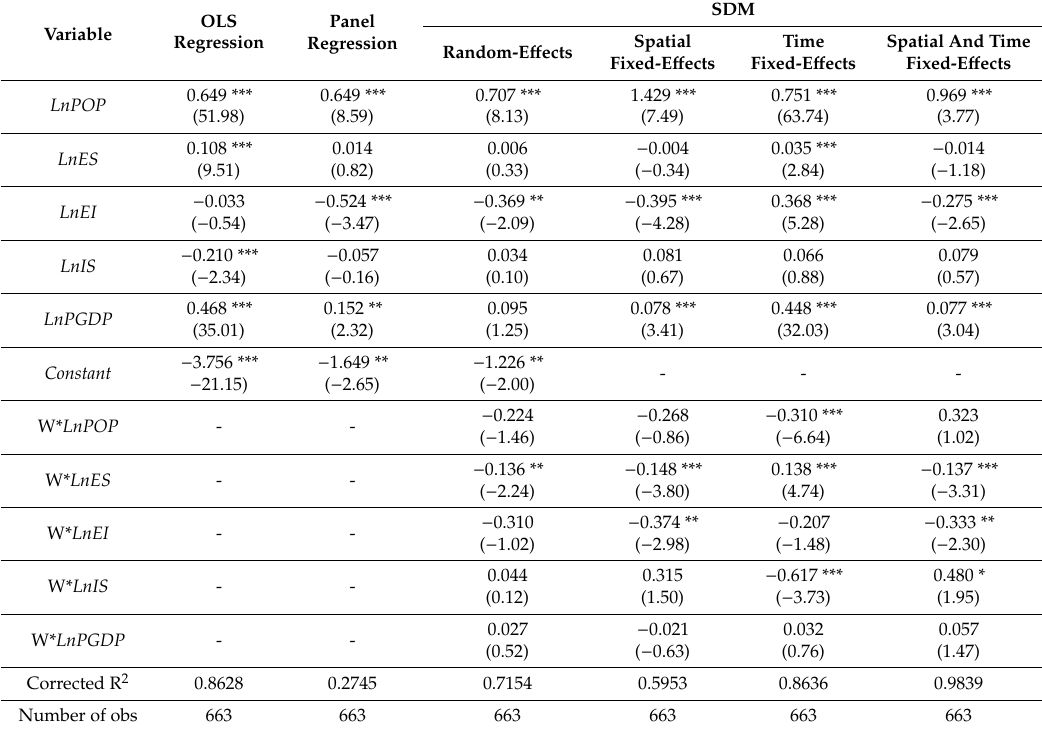
Table 6. The econometric regression results concerning the embodied GHGs in import